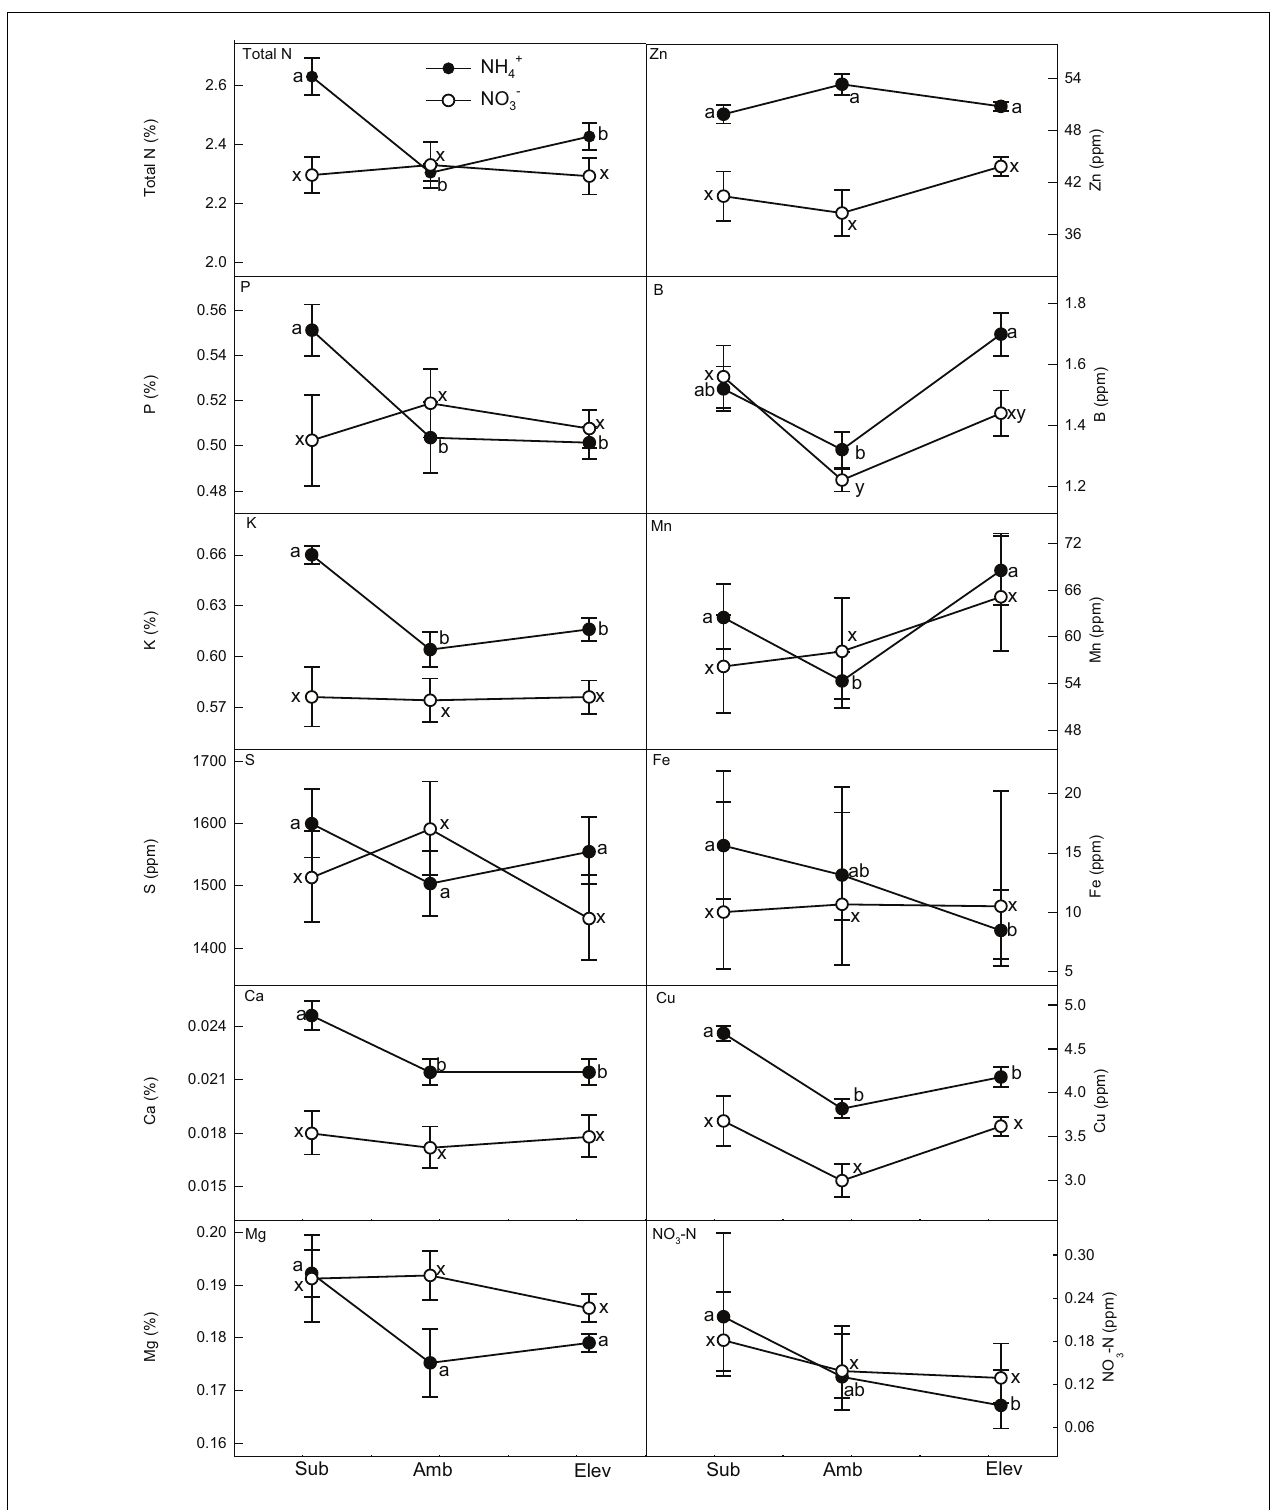
left of each frame. Differences are significant within N form if letters are different. Differences between N forms at each CO 2 concentration are generally significantly different if error bars do not overlap (see Table 1 for statistical